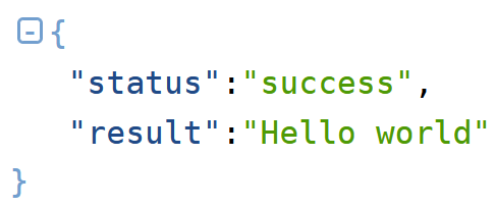
Figure 6. The returned result of simple HTTP server. Table 2. Bi-LSTM model configuration.